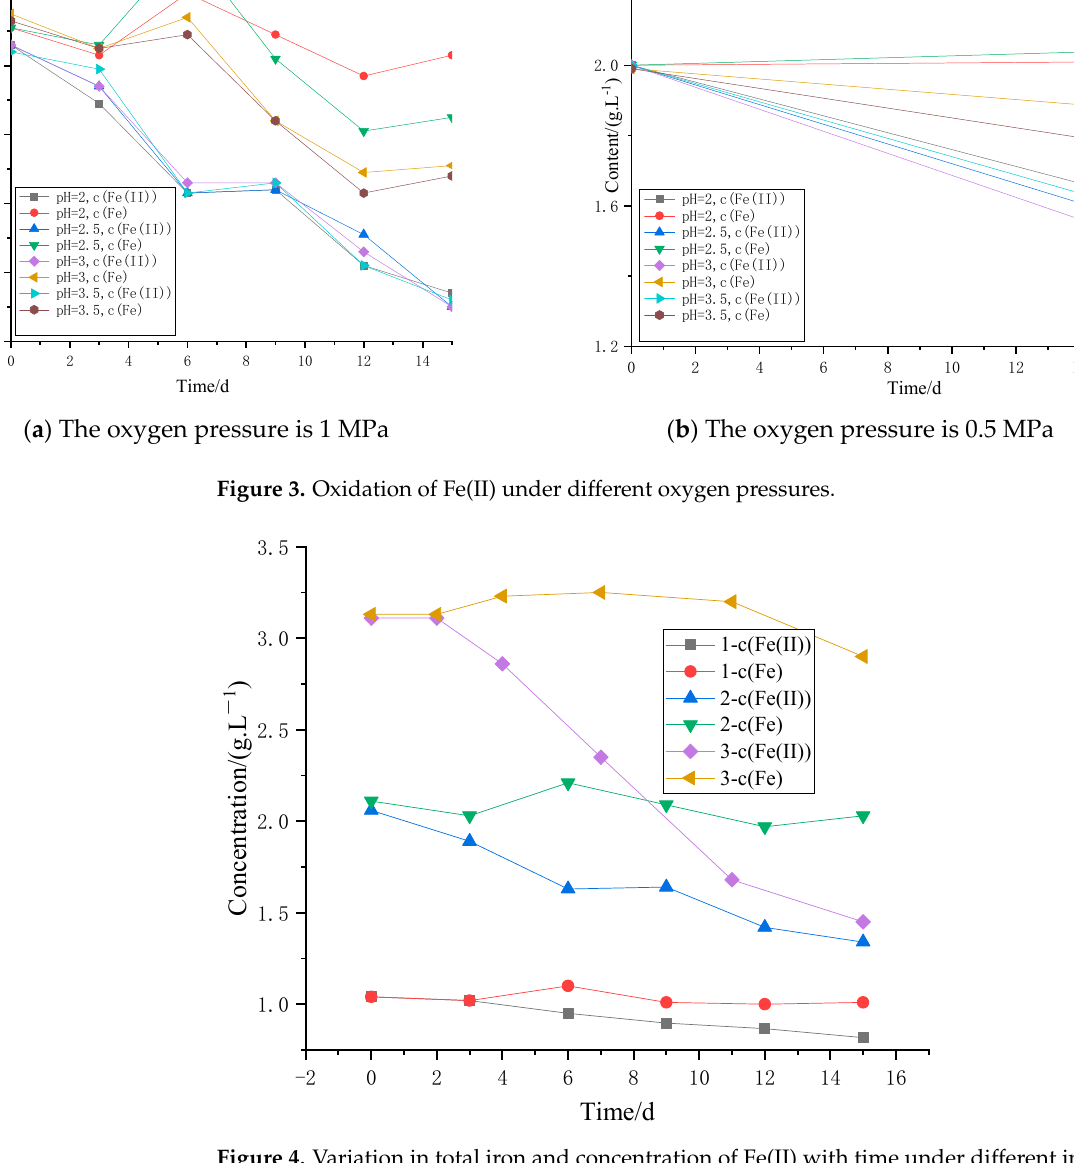
Figure 4. Variation in total iron and concentration of Fe(II) with time under different initial concen- tration of Fe(II) ( P (O 2 ) = 1.0 MPa, pH = 2).